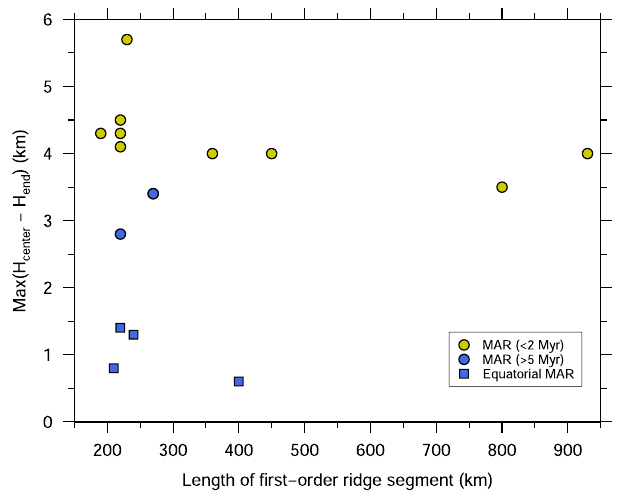
Fig. 7 | Maximum crustal thickness variation versus ridge segment length. Maximum crustal thickness variation between centres and ends of second-order ridgesegmentsversusthelengthofthecorresponding fi rst-orderridgesegmentin theAtlanticOcean.Thecrustalthicknessconstrainedbybothactive-sourceseismic dataandgravitydataisincluded.Thebluesquaresshowresultsfromthisstudyfor the equatorial Atlantic. Data sources are given in Supplementary Table 3.